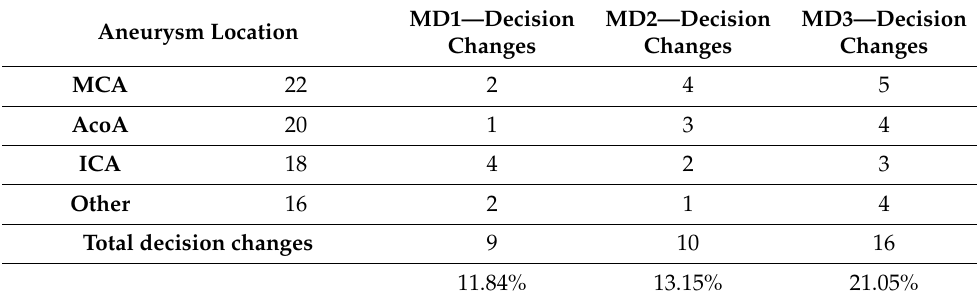
Table 3. Management decision changes for all three observers after analyzing the 3D printed